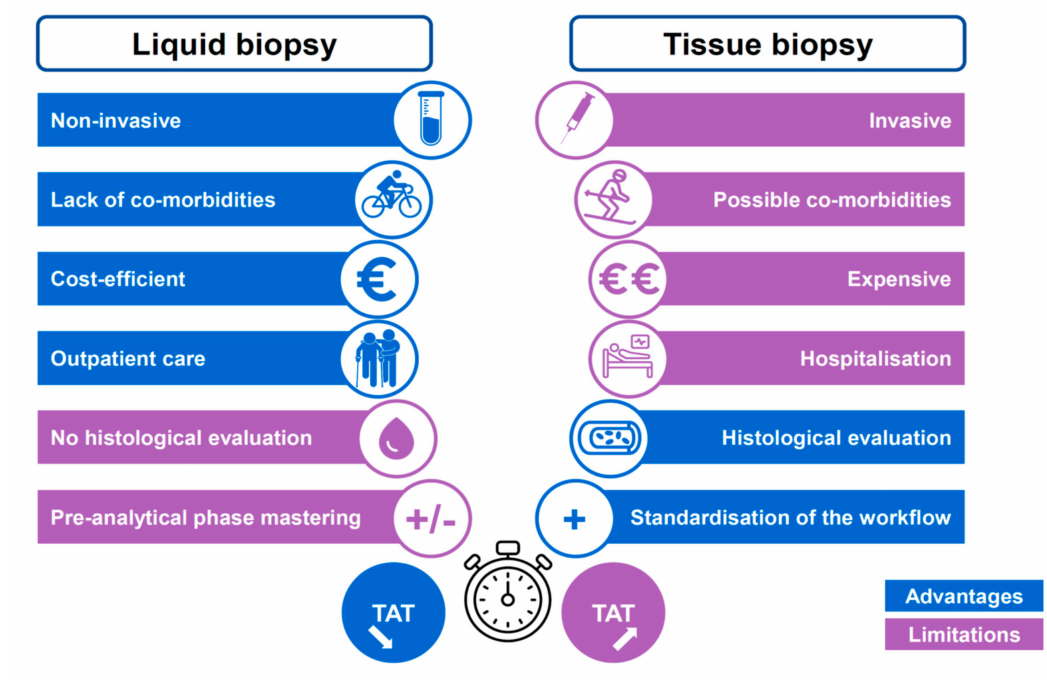
Figure 1. Main advantages and limitations of the LB and of the tissue biopsy in thoracic oncology. TAT, turnaround